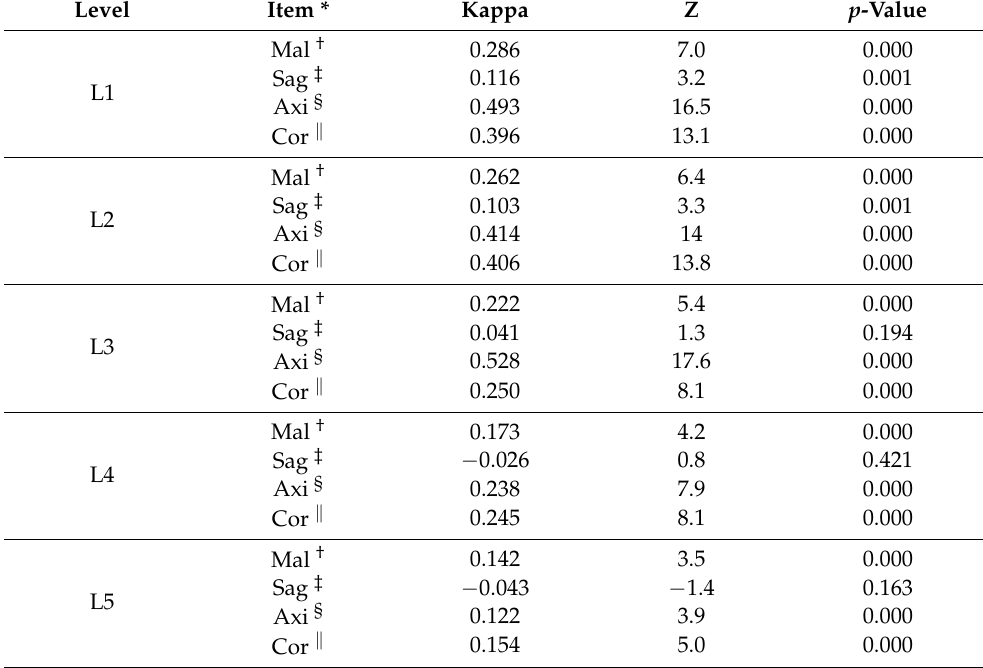
Table 3. Comparison of concordance among CMT diagnostic